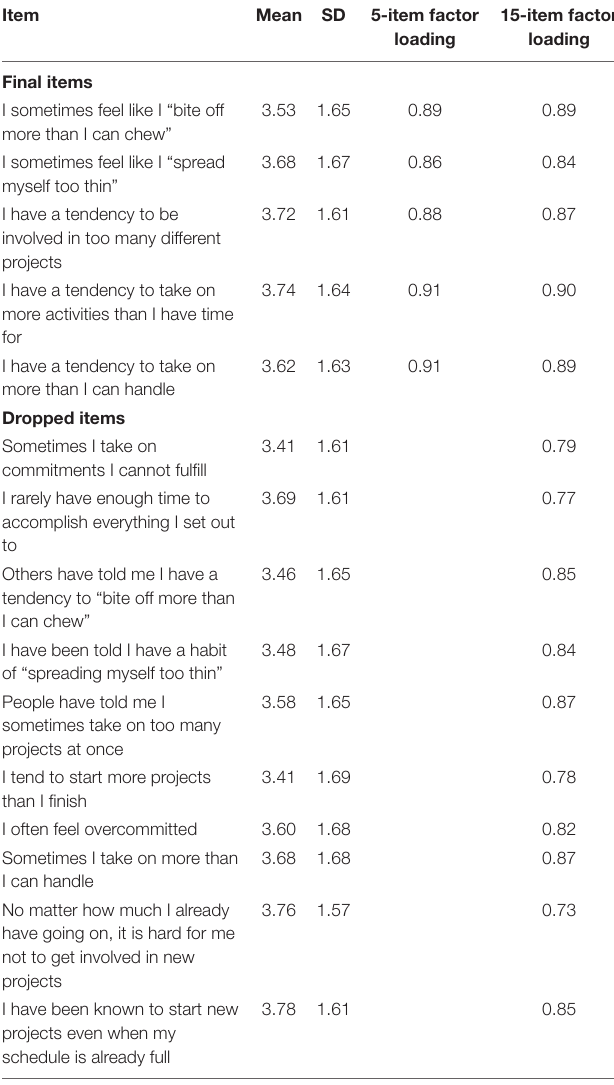
TABLE 1 | Means, standard deviations, and factor loadings from a pattern matrix of the dispositional tendency to spread oneself too thin items.